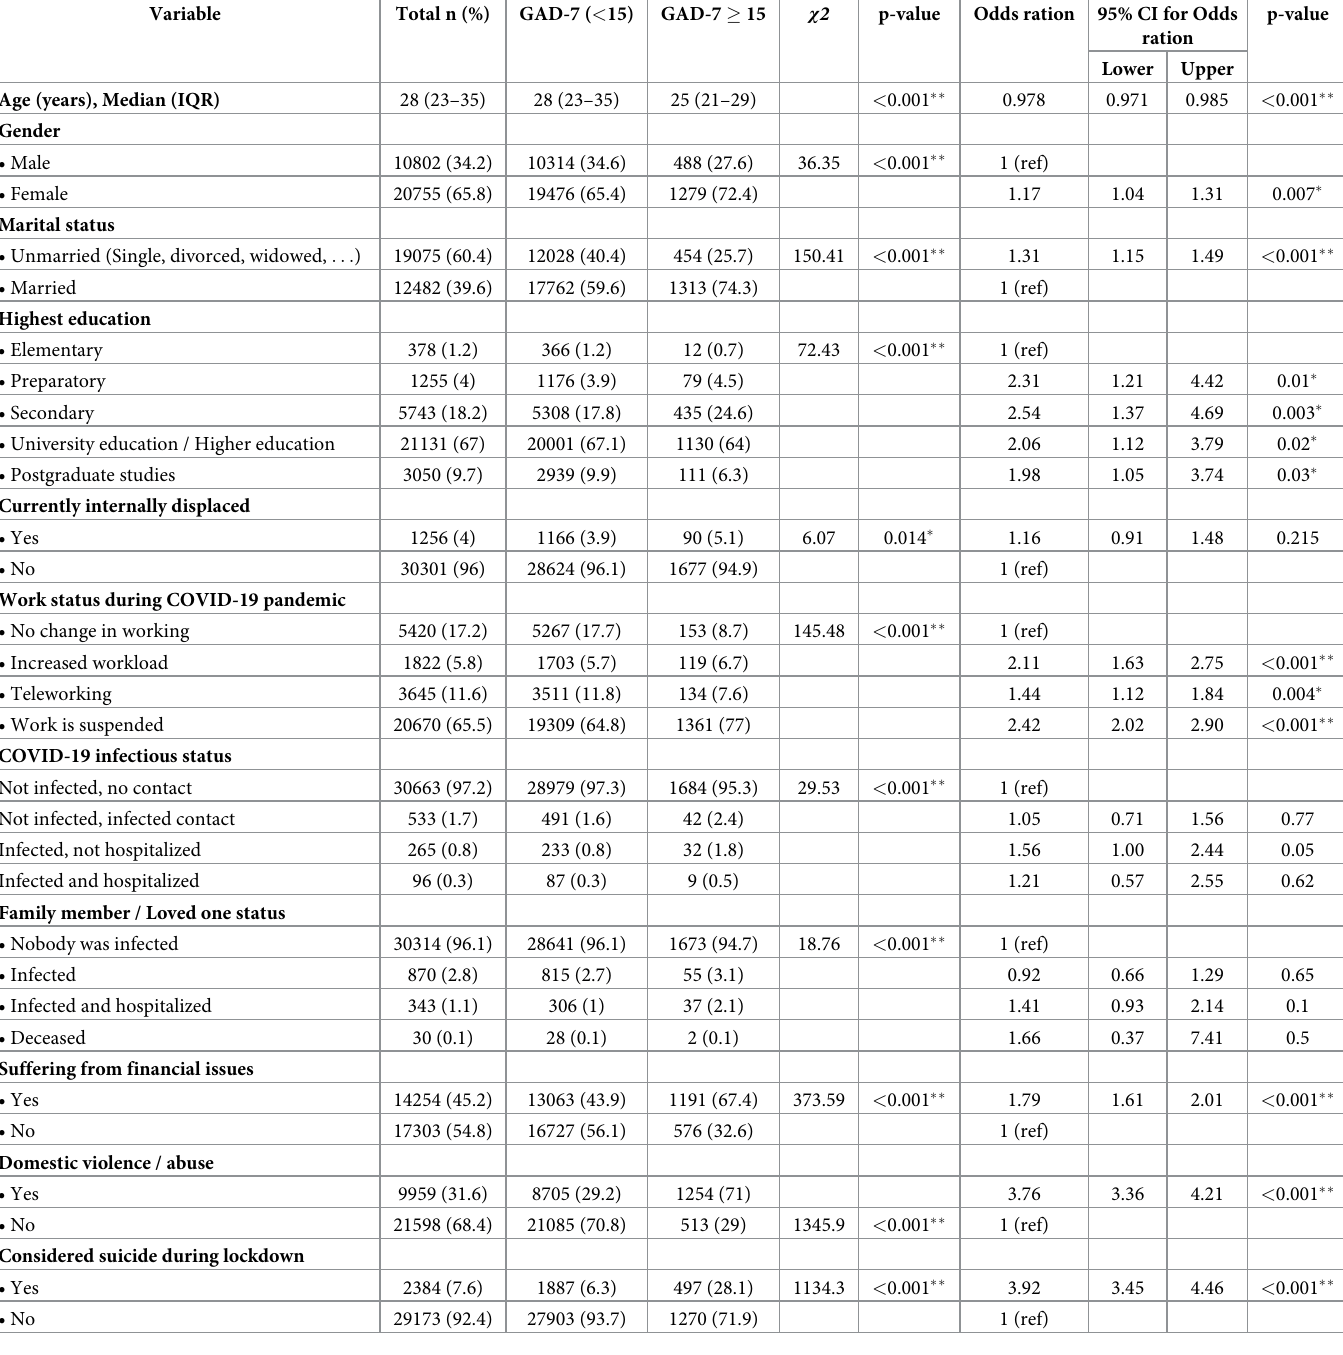
Table 4. Bivariate and multivariate binomial logistic regression analysis of severe anxiety symptoms (GAD-7 � 15).